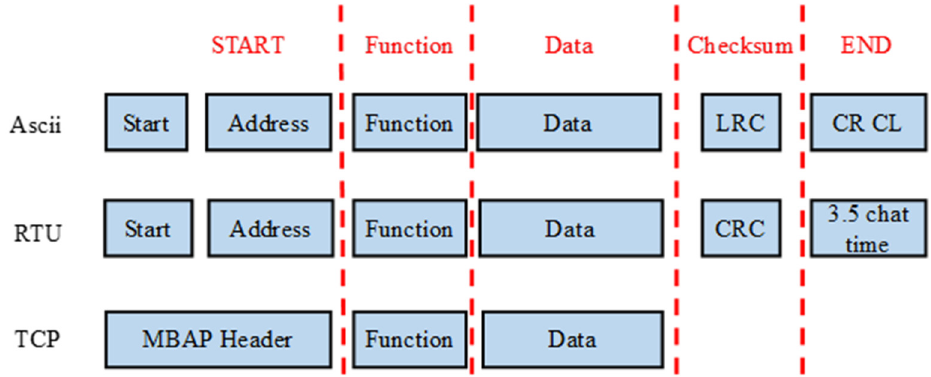
Figure 30. Communication structure.